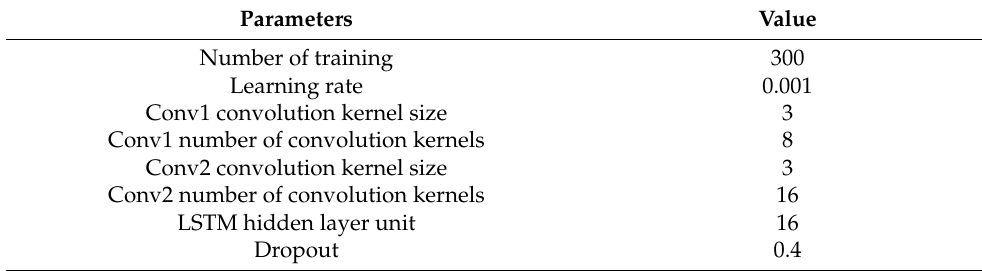
Table 1. Network parameter settings.